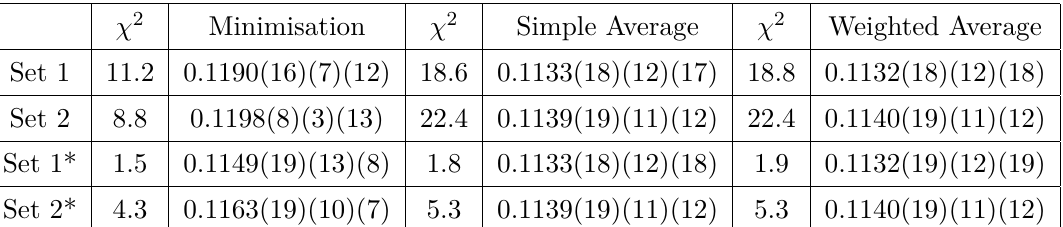
Table 5 . Averaged results for α ( n f =5) s ( M 2 from the same source are assumed to be fully correlated.